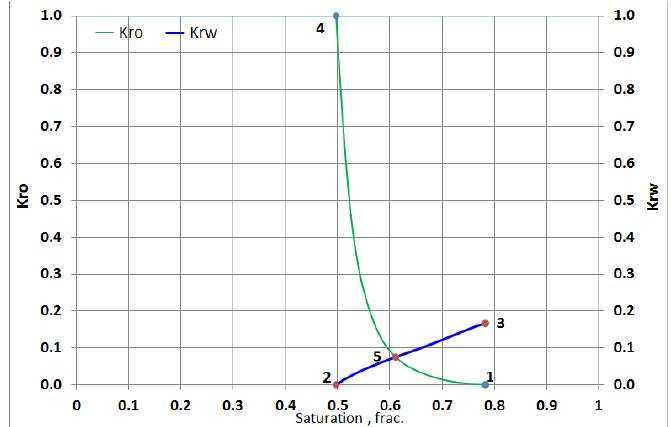
Figure 11. Relative permeability curve for Upper Bahariya reservoir